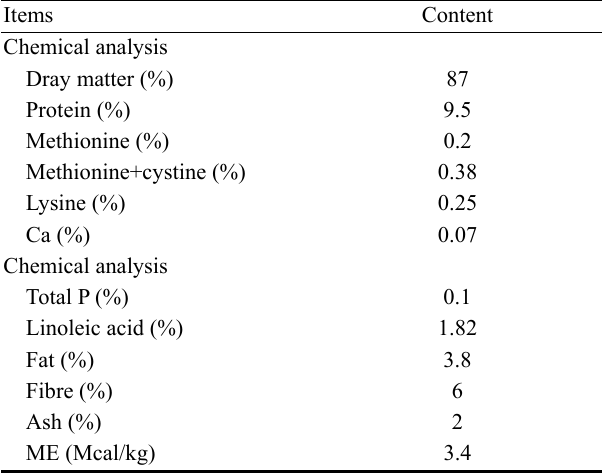
Table 1. Chemical composition and nutritive value of the supplementary feed (yellow maize) during the free-range period